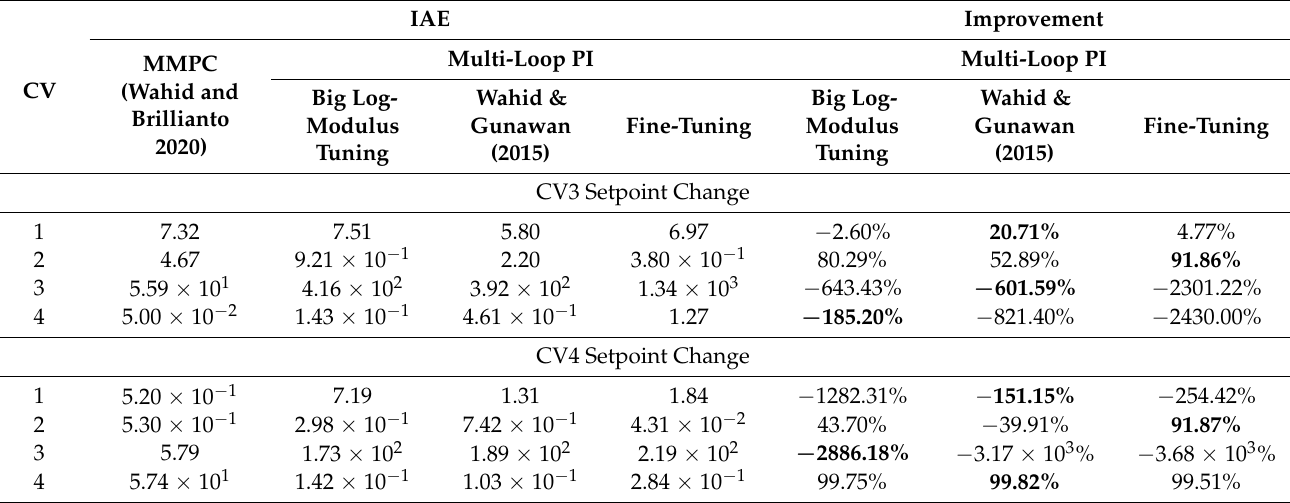
Table 13. IAE comparison of MMPC and multi-loop PI (Cont’d).